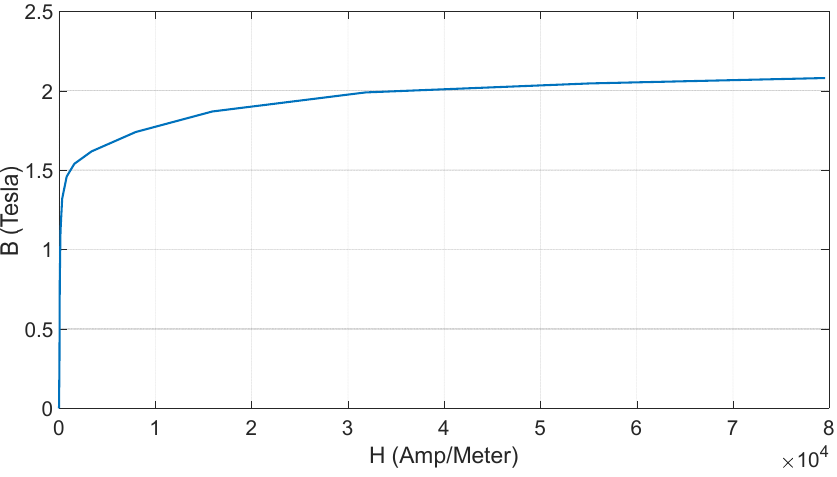
Figure 7. M-19 sheet magnetization graph.